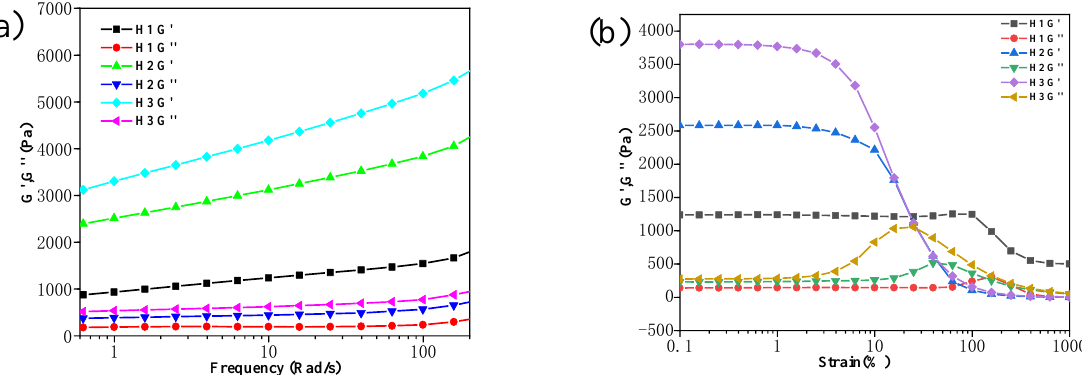
Figure 6. ( a ) Frequency sweep of three hydrogels with H1 (7% terpyridine content), H2 (10% terpyridine content), and H3 (13% terpyridine content); ( b ) strain sweep of H1 , H2 , and H3 .